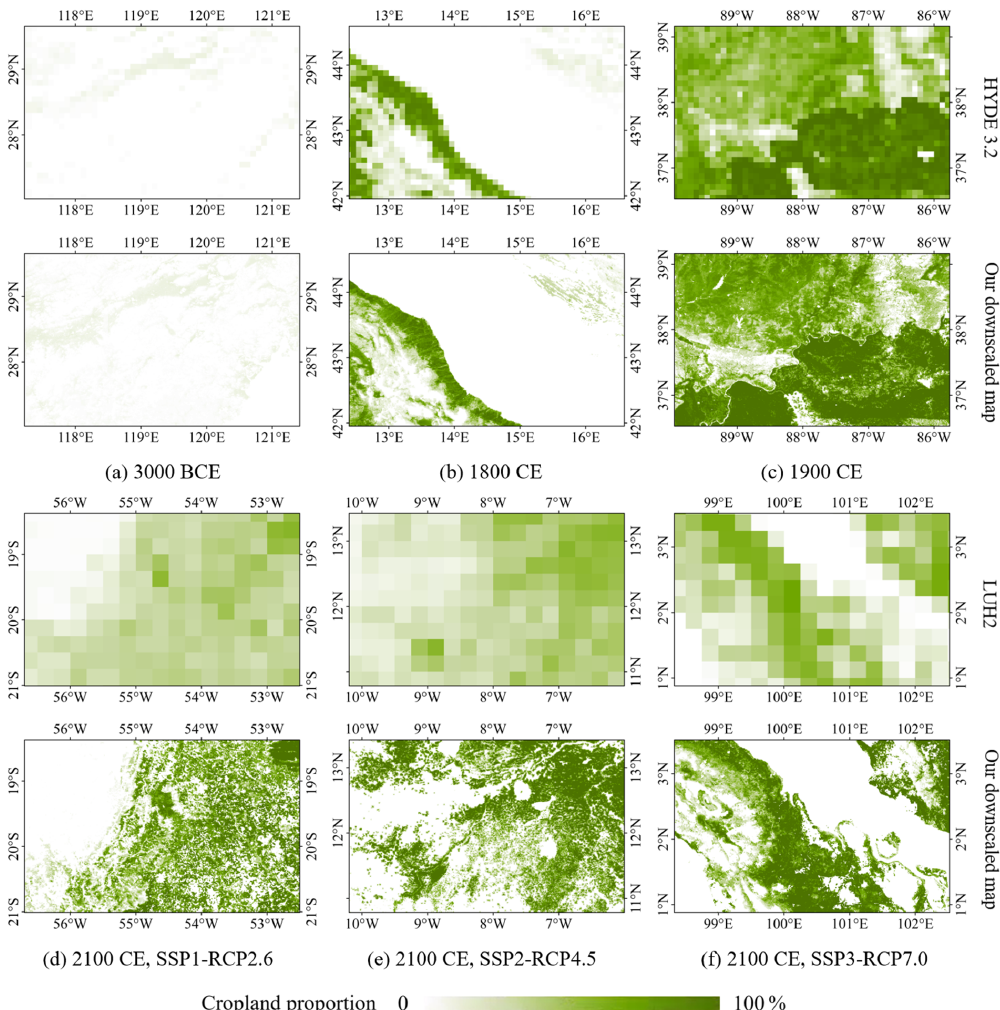
Figure 4. Visual comparison between our downscaled maps and HYDE 3.2 and LUH2 for six different areas (a–f) . The locations of image center points are as follows: (a) Zhejiang, China (28 . 338 ◦ N, 119 . 321 ◦ E), (b) Adriatic Sea (43 . 272 ◦ N, 14 . 493 ◦ E), (c) Kentucky, USA (37 . 846 ◦ N, 87 . 861 ◦ W), (d) Mato Grosso do Sul, Brazil (19 . 691 ◦ S, 54 . 599 ◦ W), (e) Koulikoro Region, Mali (12 . 105 ◦ N, 8 . 099 ◦ W), and (f) Riau, Indonesia (2 . 199 ◦ N, 100 . 425 ◦